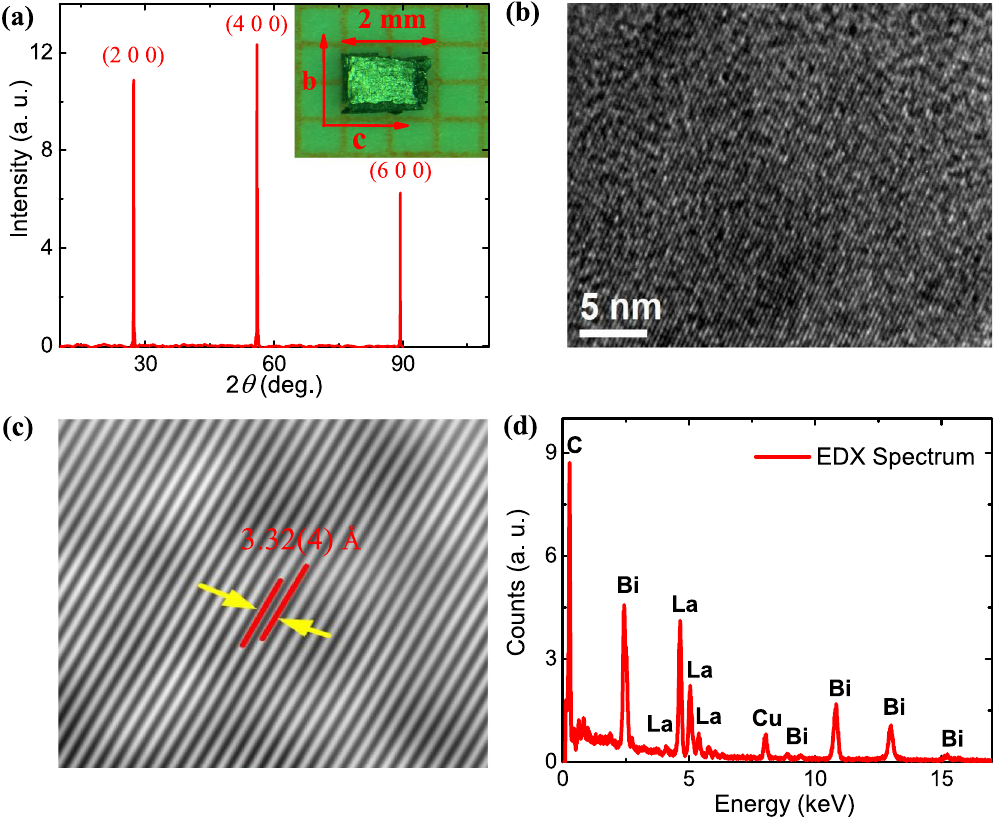
Figure 1. Characterization of as grown LaBi single crystal. ( a ) XRD pattern of the measured samples. Inset shows a typical single crystal with different crystallographic directions. ( b ) HRTEM image of the grown crystal. ( c ) Fourier filtered HRTEM image showing the interlayer spacing along (2 0 0) plane. ( d ) The EDX spectroscopy data of the grown crystals. The copper and carbon signals are coming from the carbon coated copper grid on which the samples were